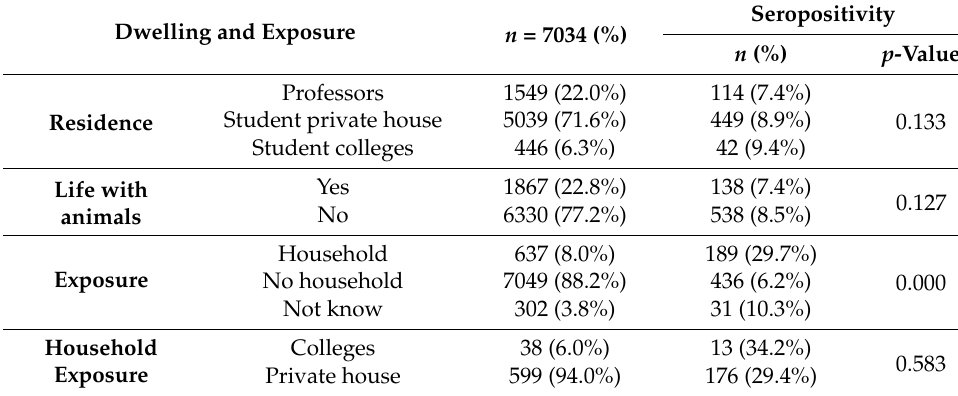
Table 2. Seroprevalence relationship with dwelling and